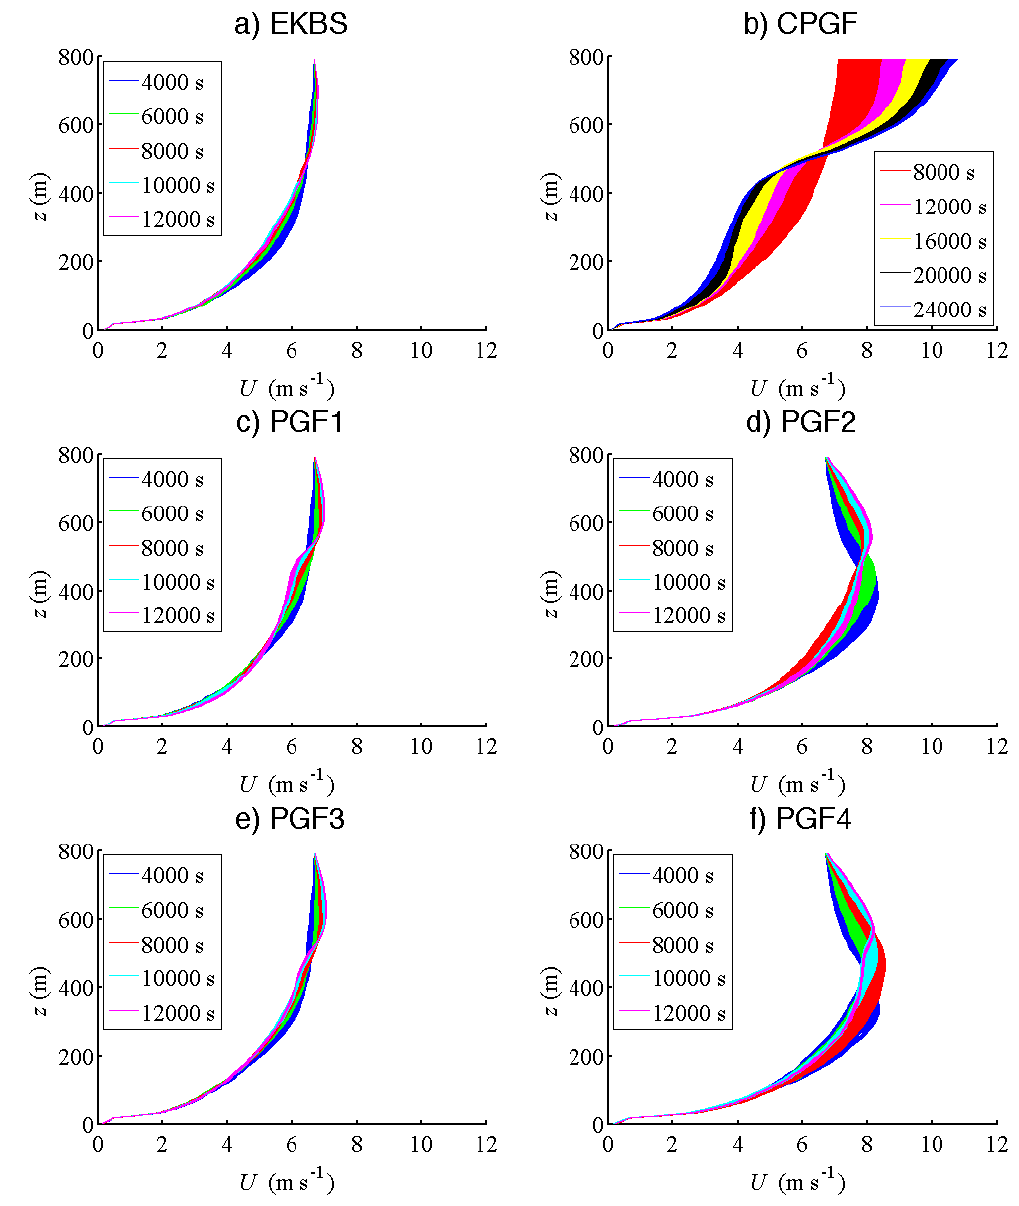
Figure 5. Temporal evolution of the instantaneous profiles of the spatially-averaged horizontal streamwise velocities for the boundary-layer simulations (1568 m × 1568 m × 800 m): ( a ) EKBS; ( b ) CPGF; ( c ) PGF1; ( d ) PGF2; ( e ) PGF3; ( f ) PGF4. Instantaneous profiles are printed every 200 s and averaged along the x - and y -axes. Profile colors are associated with a range of simulated time: 0–4000 s in blue, 4000–6000 s in green, 6000–8000 s in red, 8000–10,000 s in cyan, 10,000–12,000 s in purple. Note that a di ff erent range is used for CPGF, due to a longer time required for